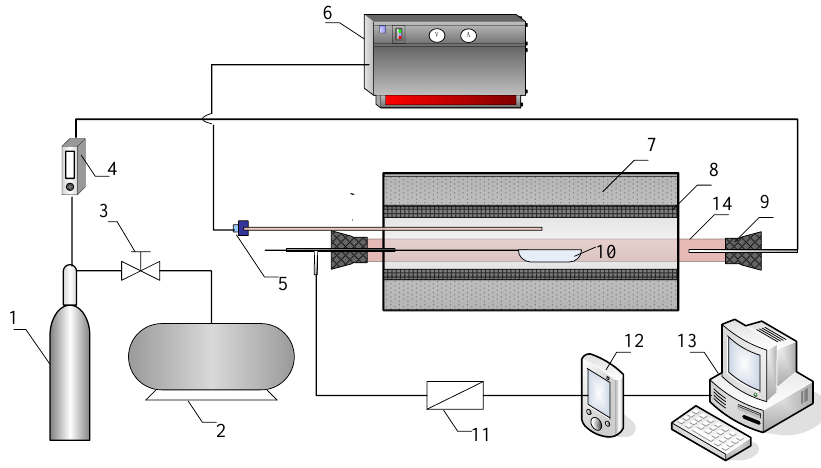
Figure 3. Schematic diagram of the experiment system: 1 air cylinder, 2 compressor, 3 pressure reducing valve, 4 rotameter, 5 thermocouple, 6 temperature controller, 7 insulating layer, 8 electric heating element, 9 rubber plug, 10 alundum crucible, 11 filter, 12 gas analyser, 13 computer, 14 corundum